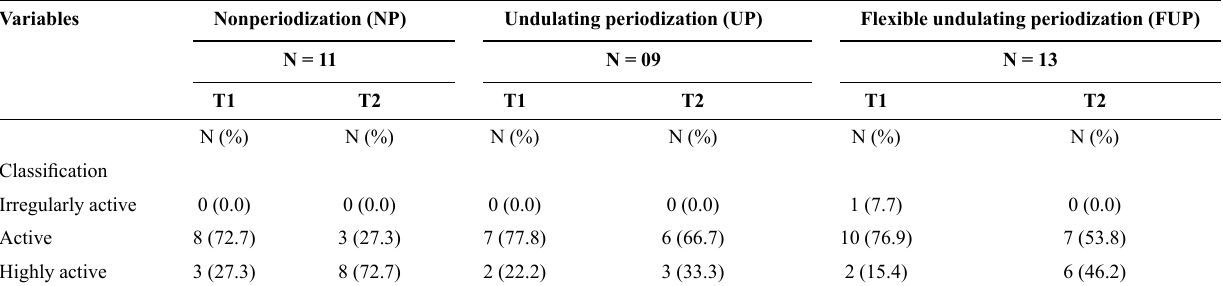
Table 5 - Classification of the physical activity level of the participants as measured using the IPAQ-Short Form, by physical training group and evalua- tion time. Variables